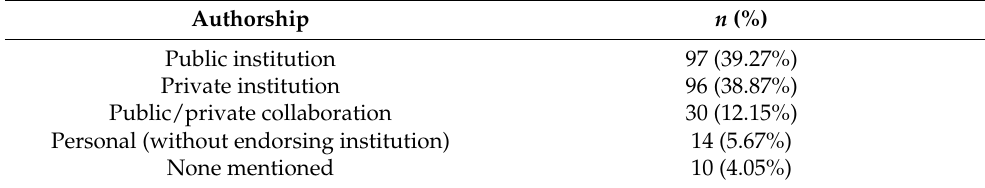
Table 1. Authorship characteristics of infographics on antibiotics included in the study.